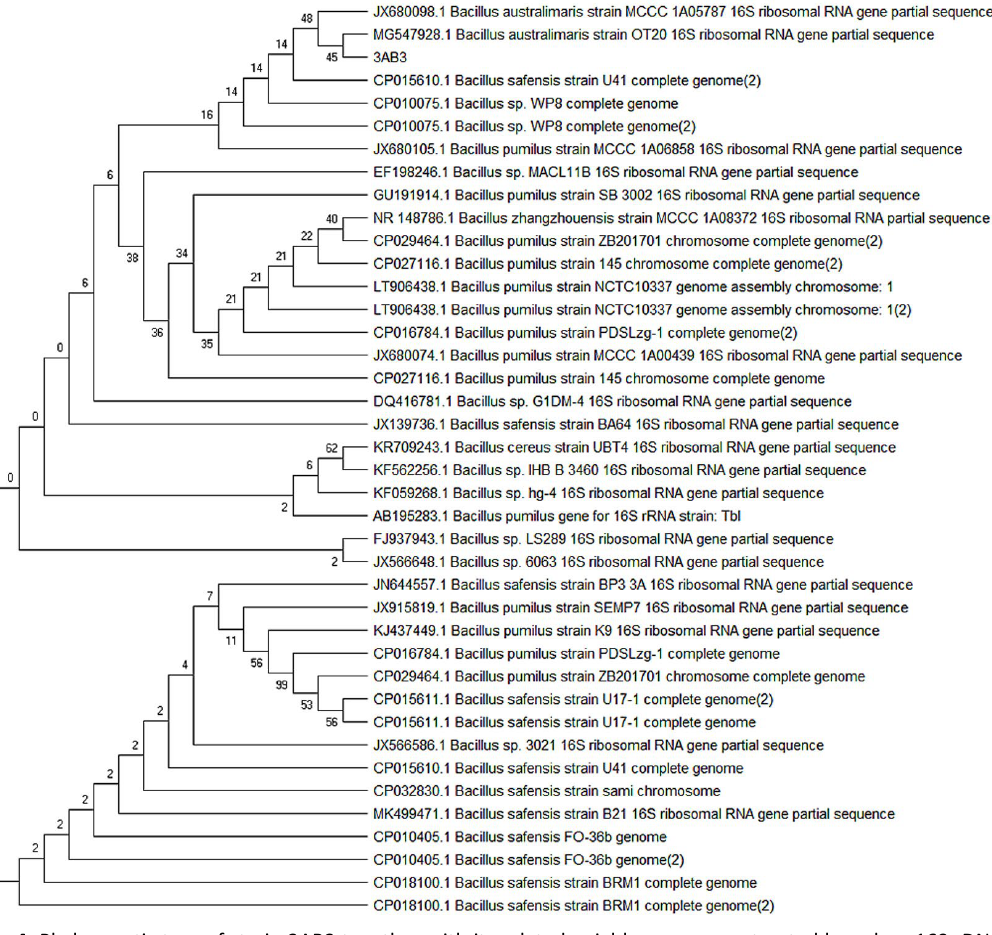
Fig. 4. Phylogenetic tree of strain 3AB3 together with its related neighbors was constructed based on 16S rDNA sequence using neighbor-joining and maximum likelihood method. GenBank accession numbers are given in